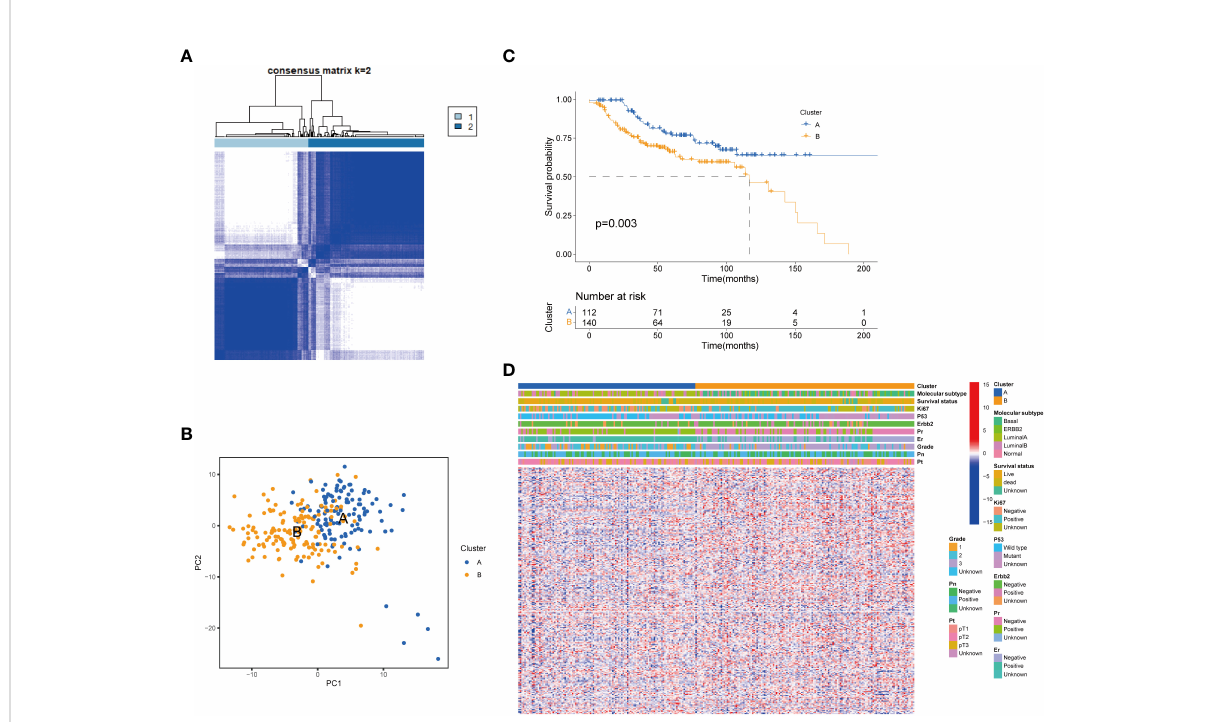
FIGURE 2 Senescence-related genes and the clinicopathological and biological characteristics of the two distinct subtypes of samples divided by consistent clustering. (A) Consensus matrix heatmap de fi ning two clusters ( k = 2) and their correlation area. (B) PCA analysis showing a remarkable difference in transcriptomes between the two subtypes. (C) Univariate analysis showing 278 senescence-related genes related to the RFS time. (D) Differences in clinicopathologic features and expression levels of senescence-related genes between the two distinct subtypes. PCA, principal components analysis; RFS,